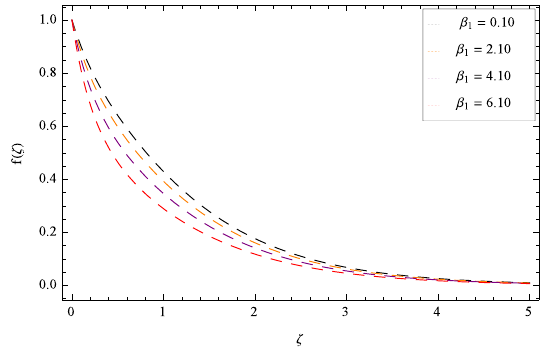
Figure 2. Pattern of graph curves on account of β 1 .